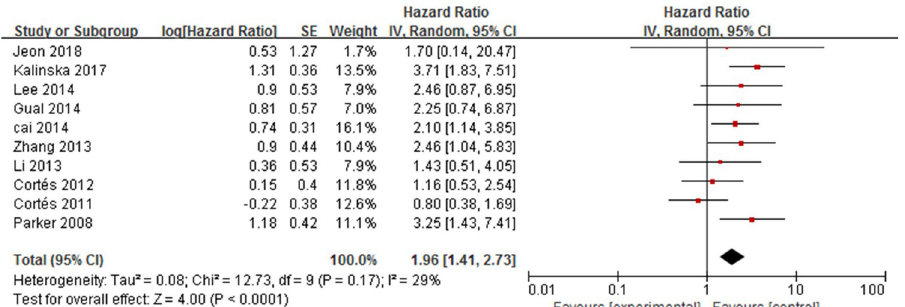
Fig 15. Forest plot of the association between heart disease and bullous pemphigoid mortality.